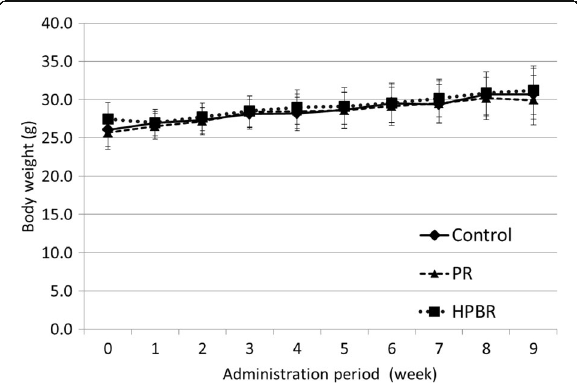
Fig. 2 Change in body weight during the administration. PR: polished rice, HPBR: highly water pressurized brown rice. Mean±SD, n =9 (control and HPBR groups) or 8 (PR group)